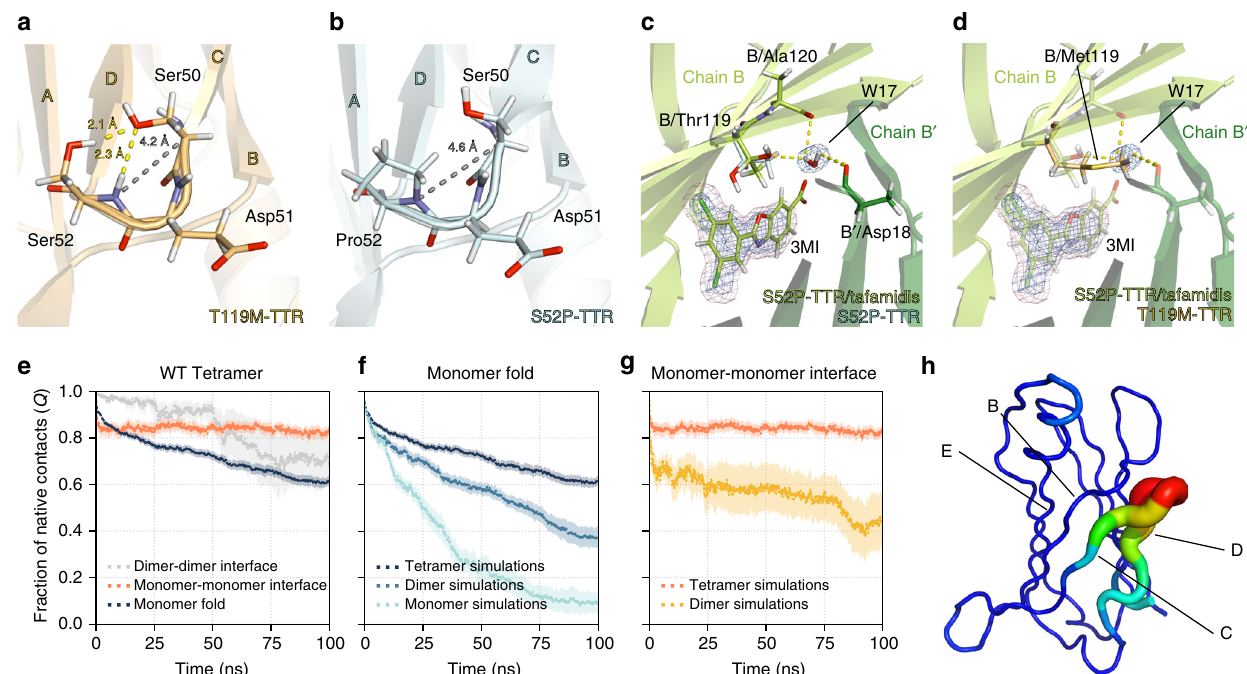
Fig. 3 Neutron structures and molecular dynamics results. a In the T119M mutant (as well as in the WT; not shown), the Ser52 residue forms two hydrogen bonds ( yellow dash lines ) with the Ser50 residue. The distance between Ser50-C α and the amide-N of Ser52 is 4.2 Å (grey), and it is the same in the WT (not shown). b In the S52P mutant, due to the absence of the hydrogen bonds between Pro52 and Ser50, the distances between Ser50-C α and the amide- N of Pro52 is longer (4.6 Å), creating a looser CD loop. c Binding of tafamidis (3MI) results in a change of orientation for residue Thr119 (cyan, before binding; green, after binding). In the S52P/tafamidis complex, the hydroxyl side chain of Thr119 forms a hydrogen bond to a water molecule. d The water molecule in the S52P/tafamidis complex occupies the same position as the side chain of Met119 residue (light orange) in the non-pathogenic T119M mutant. The binding site between chain B and B ′ is shown. The blue and magenta mesh show the 2 F o -F c neutron scattering length density map and the 2 F o - F c X-ray electron density map, respectively. Maps were contoured at 1.5 σ . e – g Loss of native fold and contacts in WT-TTR during high-temperature MD simulations with the Amber99sb*-ILDNP force fi eld; shown are the mean and its standard error from 10 simulation repeats (results for Charmm36 are in Supplementary Figure 6). e Degree of disruption of the monomer fold, the monomer – monomer interface, and the dimer – dimer interface, when simulating the WT tetramer over the course of 100 ns. f Degree of unfolding of TTR monomers as part of a tetramer, dimer, or monomer in solution. g Degree